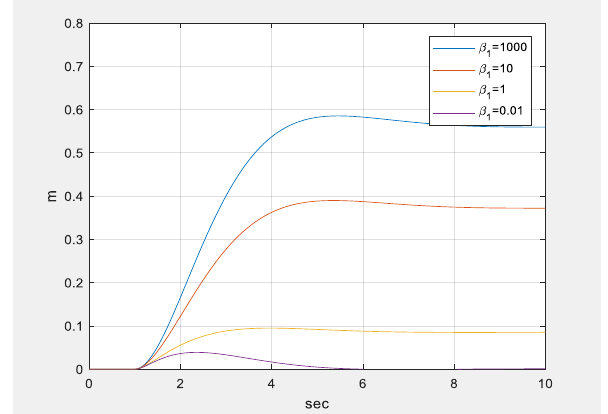
a , of the simulator (output of x